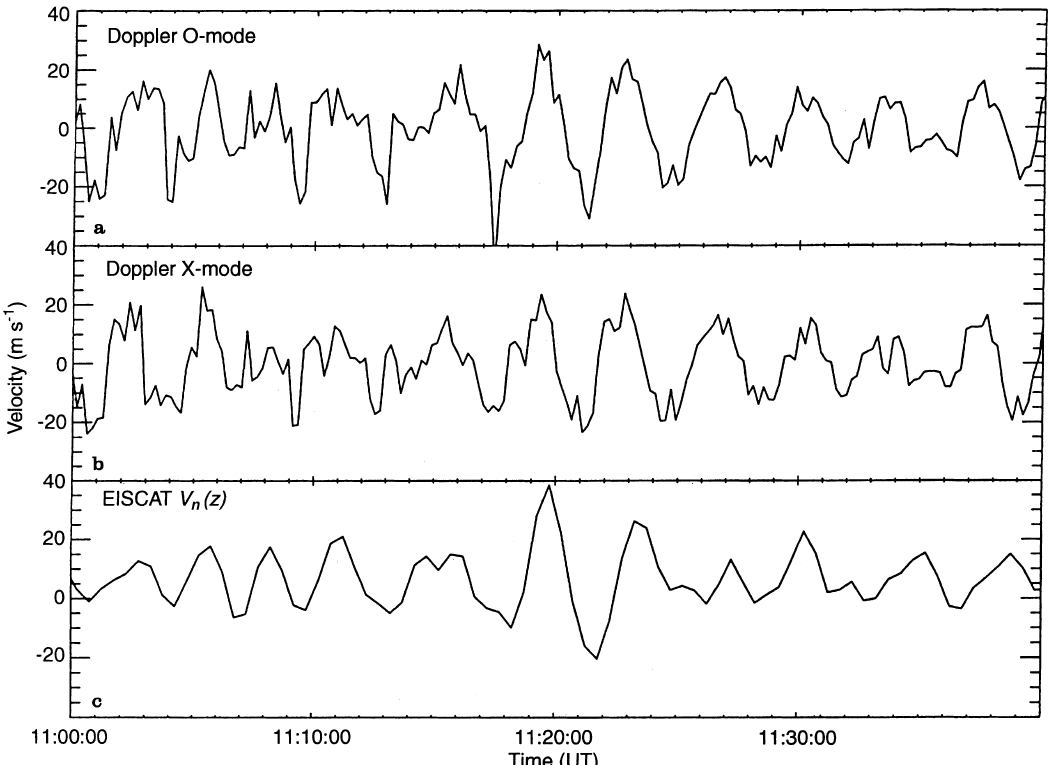
interval 11.00–11.40 UT on 13 February 1996. Data have been filtered to exclude periods outside the range 30–400 s (a, b) and 120–400 s (c). In each case the ordinate axes display relative